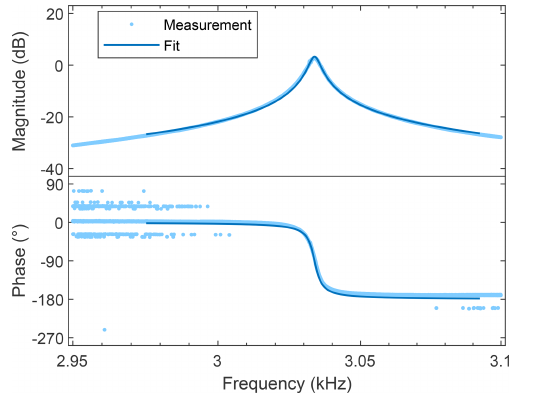
Figure 7. Bode plot of the first out-of-plane bending-mode reso- nance peak. Measured values (light blue dots) and fit of the model (dark blue